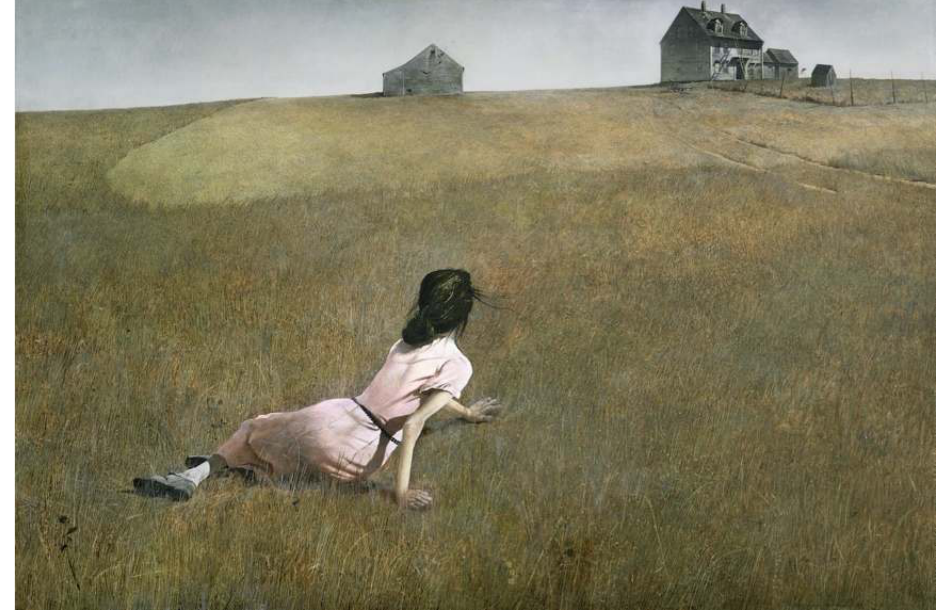
Museum of Modern Art, New York,